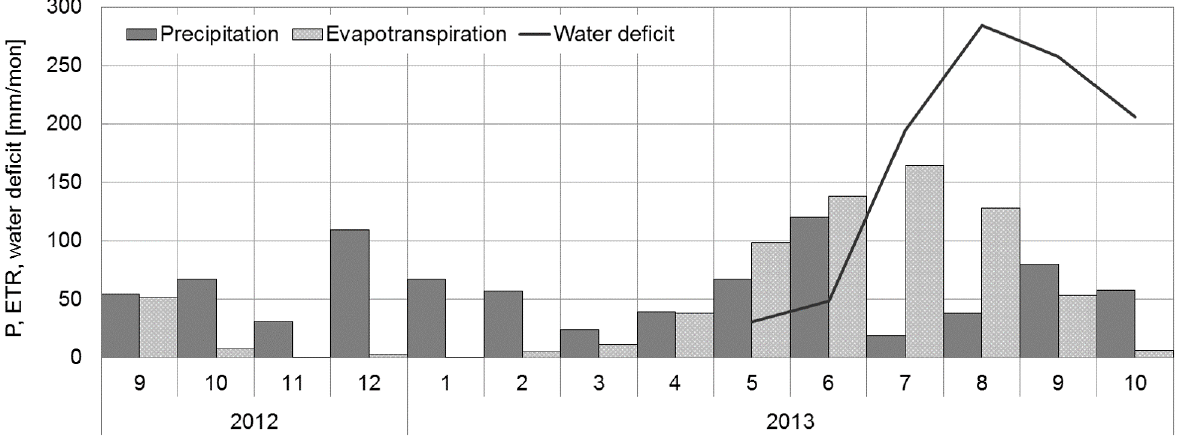
Figure 5. Monthly precipitation ( P ), evapotranspiration ( ETR ), and resulting cumulative water deficit